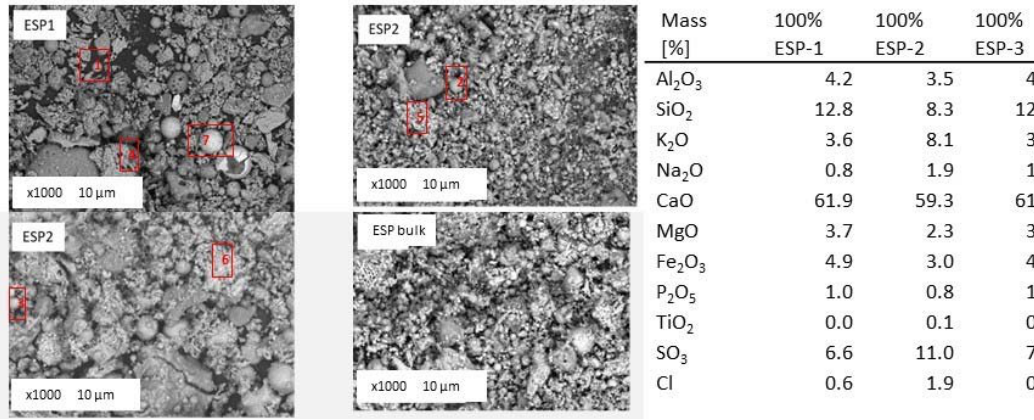
Figure 17. Backscattered electron images of fly ash from 100% thermal share Cynara combustion.